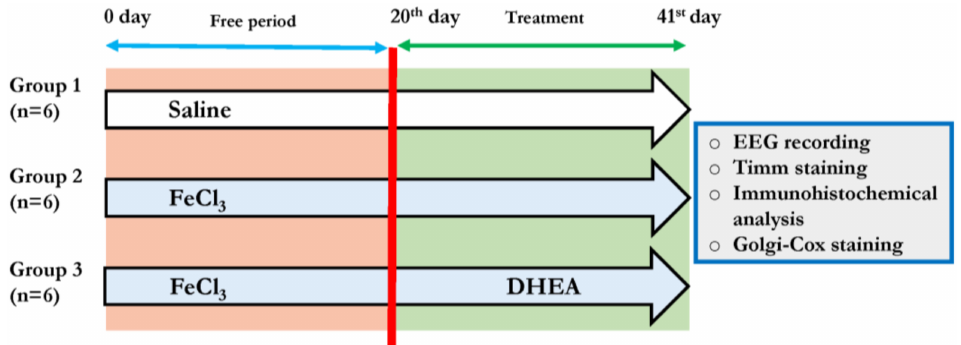
Figure 1. Schematic illustration of the treatment paradigm and assay parameters of the